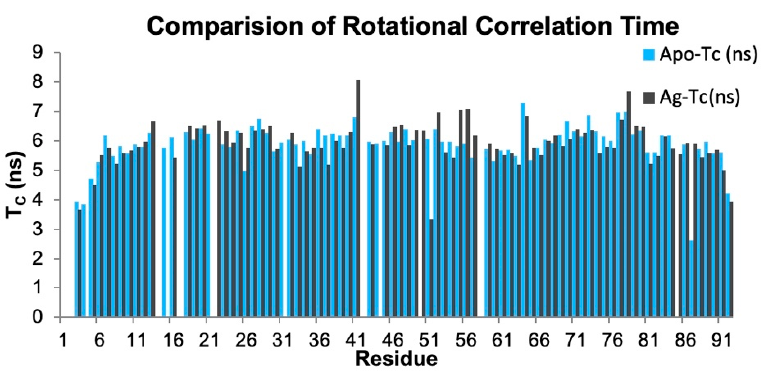
Figure 5. Rotational correlation time of both the apo and silver metalated protein. Analysis of the apo protein (blue) and the silver metalated protein (gray).